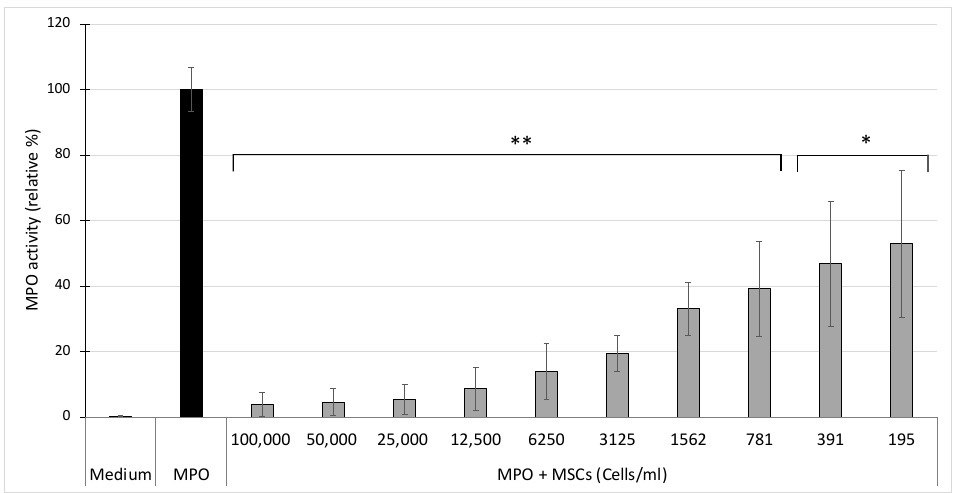
Figure 3. Effect of MSCs on the activity of equine MPO measured by SIEFED. Results from five independent experiments ( n = 5) with 2 technical replicates for each point, including 4 horses for mdMSCs. Means ± SD are shown in relative percentages versus MPO control performed without mdMSCs and defined as 100% response. Statistical analysis was considered for 5 independent experiments ** p < 0.01, * p < 0.05 vs. MPO.